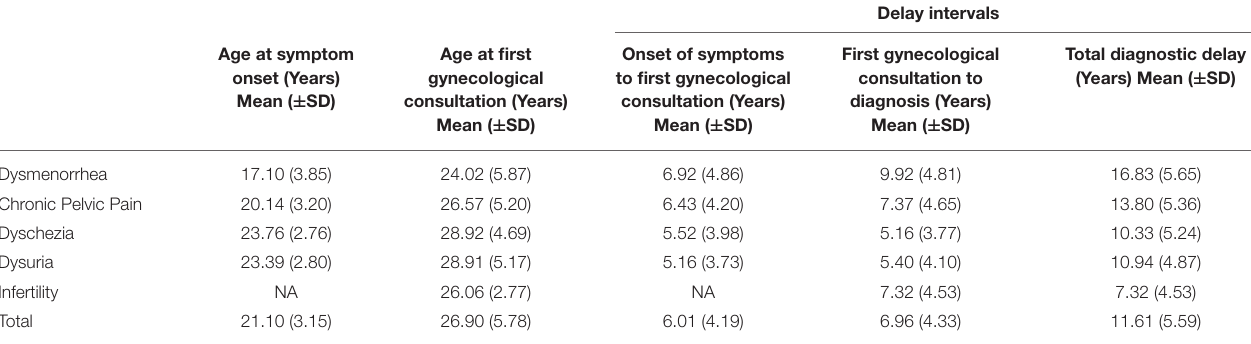
TABLE 4 | Symptom onset and diagnostic delay of endometriosis from age at time of diagnosis [years: 34.04 (SD: 4.81)].